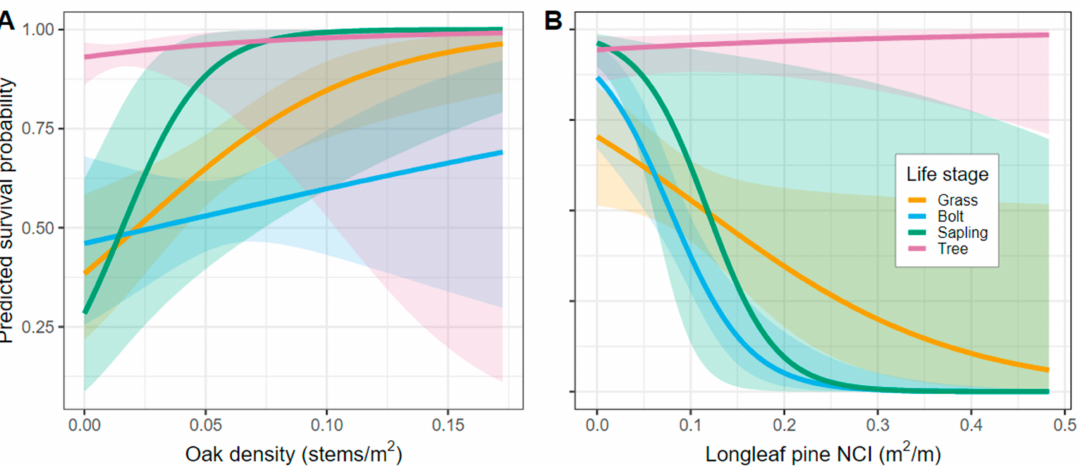
Figure 5. Survival probability as a function of oak (i.e., heterospecific) density ( A ) and longleaf pine NCI ( B ), with values partitioned by life stage. Results shown from full GLMM containing interactions between life stage and neighborhood metrics as well covariates for gap fraction, slope, understory density, and ground vegetation density. Shaded ribbons indicate 95% confidence intervals of parameter estimates by life stage. See Appendix A Figures A2 and A3 for individual panels per